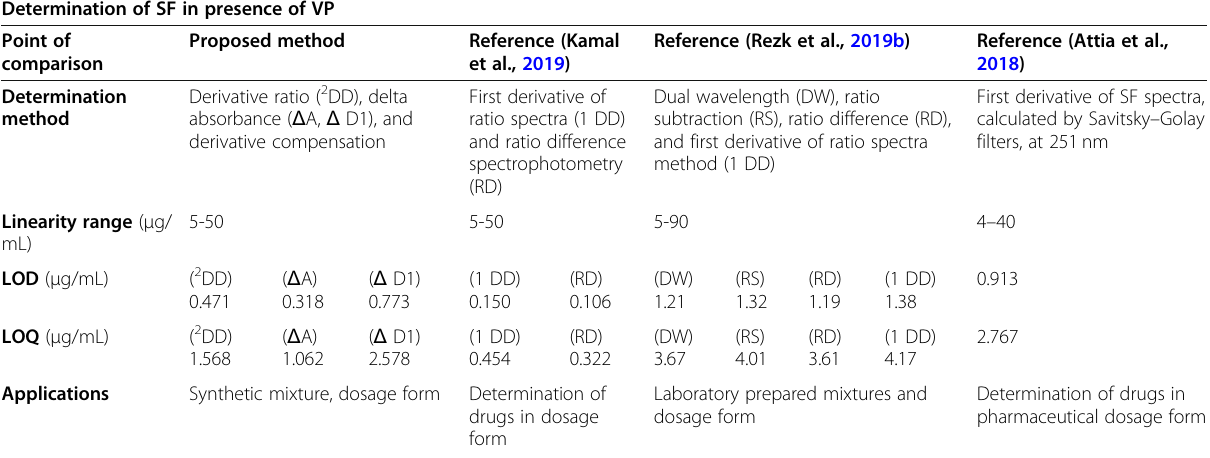
Table 5 Comparison of the proposed method for SF and VP determination with other reported methods: Determination of SF in presence of